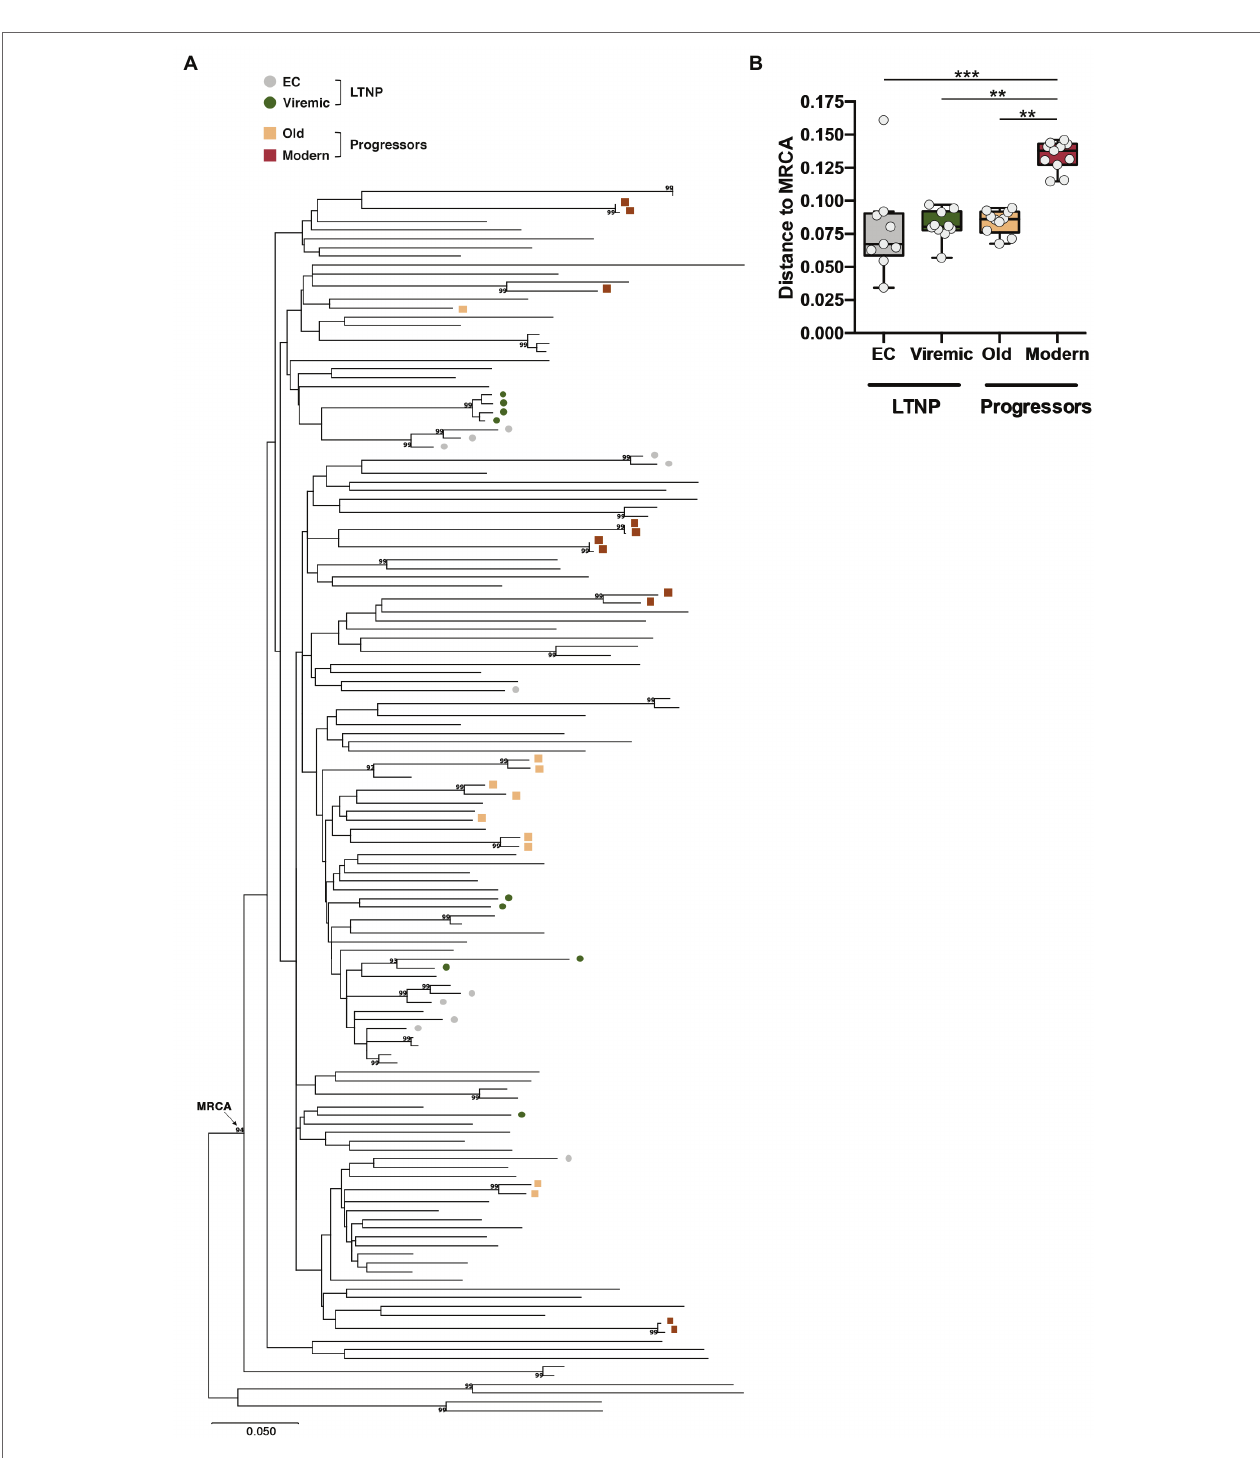
FIGURE 2 | Phylogenetic analysis of the viral envelope sequences relate to the most recent common ancestor (MRCA). (A) Phylogenetic tree and subtype B MRCA were inferred with complete viral env nucleotide sequences by using the Maximum Likelihood method and General Time Reversible model using MEGA X software X (Kumar et al., 2018). The percentage of trees in which the associated taxa clustered together with values over 90% is shown next to the branches. The tree is drawn to scale, with branch lengths measured in the number of substitutions per site. The phylogenetic analysis of the studied viral sequence (the env gene for LTNP-ECs and vLTNPs, and Old and Modern progressors) did not reveal relationships between the different groups and no clustering except for those sequences obtained from the same individual. (B) Box-plot representation of the genetic distances of the viral env sequences to the MRCA of LTNP viruses (EC and Viremic) compared with the MRCA-genetic distances of viruses obtained from HIV-1+ progressor individuals (Old and Modern); values of p (Kruskal–Wallis test) for comparison between all groups are shown. When indicated, p values are ** p <0.05 and *** p